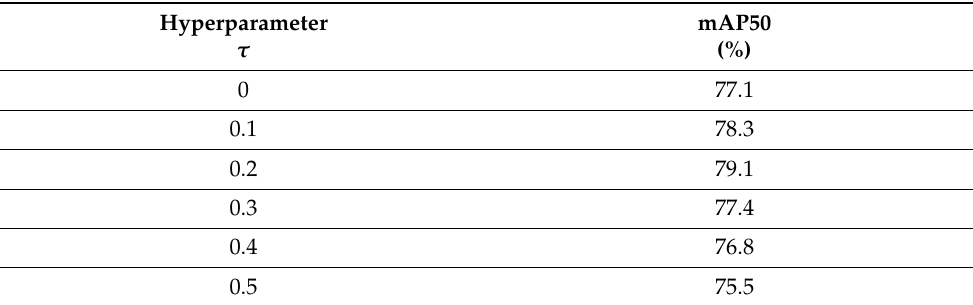
Table 4. Quantitative results for evaluating the effects according to hyperparameter τ for the high- frequency extraction on the FLIR